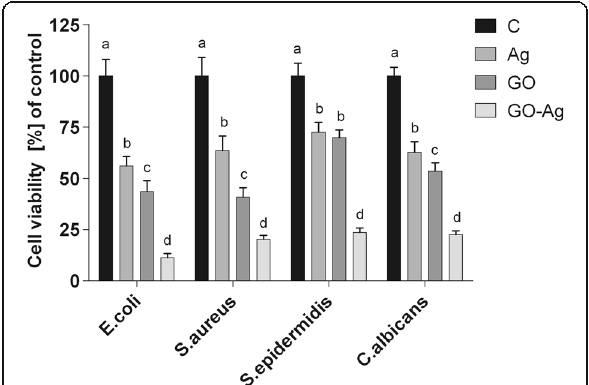
Fig. 11 Foils coated with nanomaterials decrease E . coli , S . aureus , S . epidermidis , and C . albicans viability. Viability of bacteria and yeast after incubation on foils coated with Ag-NPs, GO, and GO-Ag at 37 °C for 24 h was assessed with Presto Blue assay. C control group (foil without nanoparticles), Ag foil coated with silver nanoparticles, GO foil coated with graphene oxide, GO-Ag foil coated with composite of graphene oxide and silver nanoparticles. Note: The columns with different letters (a – d) indicate significant differences between the concentrations ( P =0.001); error bars are standard deviations